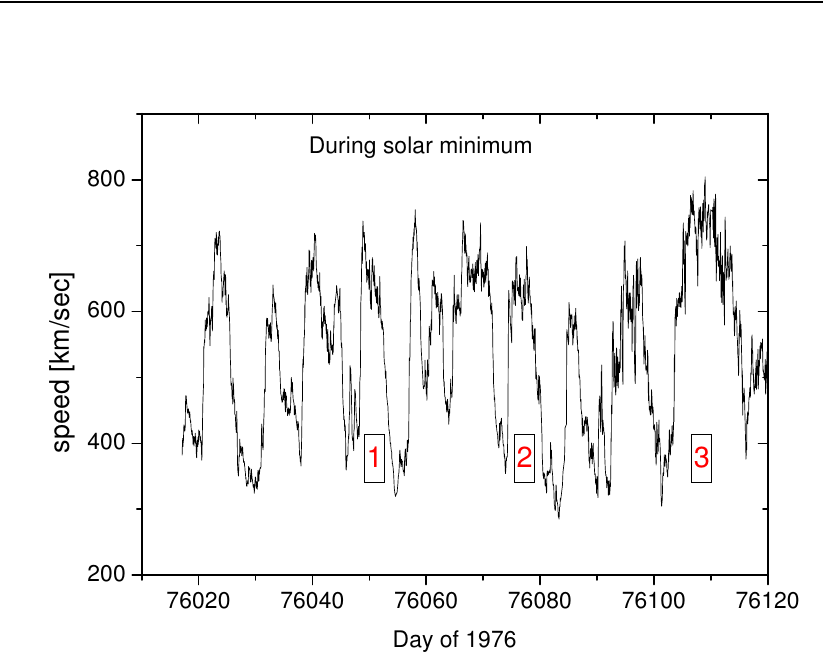
Figure 16: High velocity streams and slow wind as seen in the ecliptic during solar minimum as func- tion of time [ 𝑦𝑦𝑑𝑑𝑑 ]. Streams identified by labels are the same co-rotating stream observed by Helios 2, during its primary mission to the Sun in 1976, at different heliocentric distances. These streams, named “The Bavassano–Villante streams” after Tu and Marsch (1995a), have been of fundamental importance in understanding the radial evolution of MHD turbulence in the solar wind.